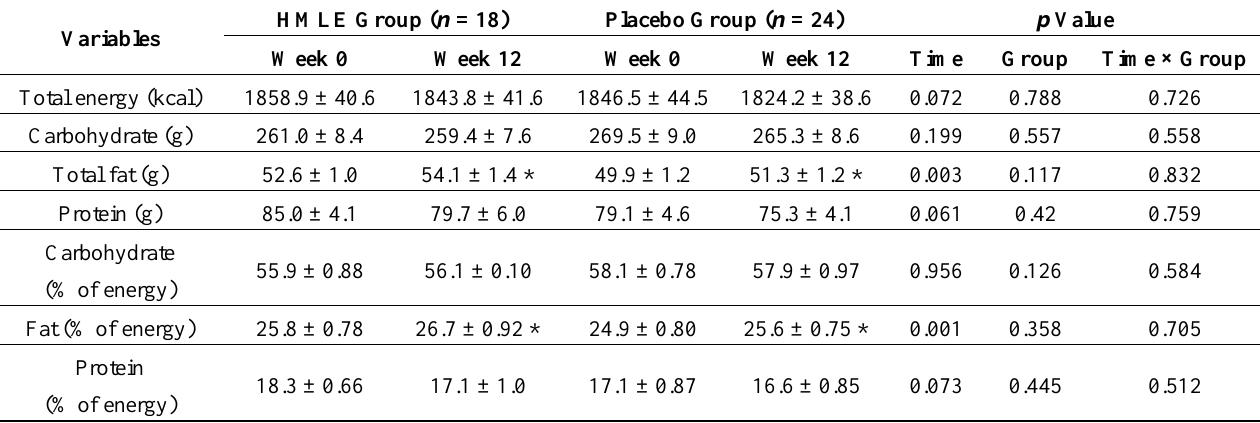
Table 5. Dietary intakes at baseline and at week 12 of participants completing the